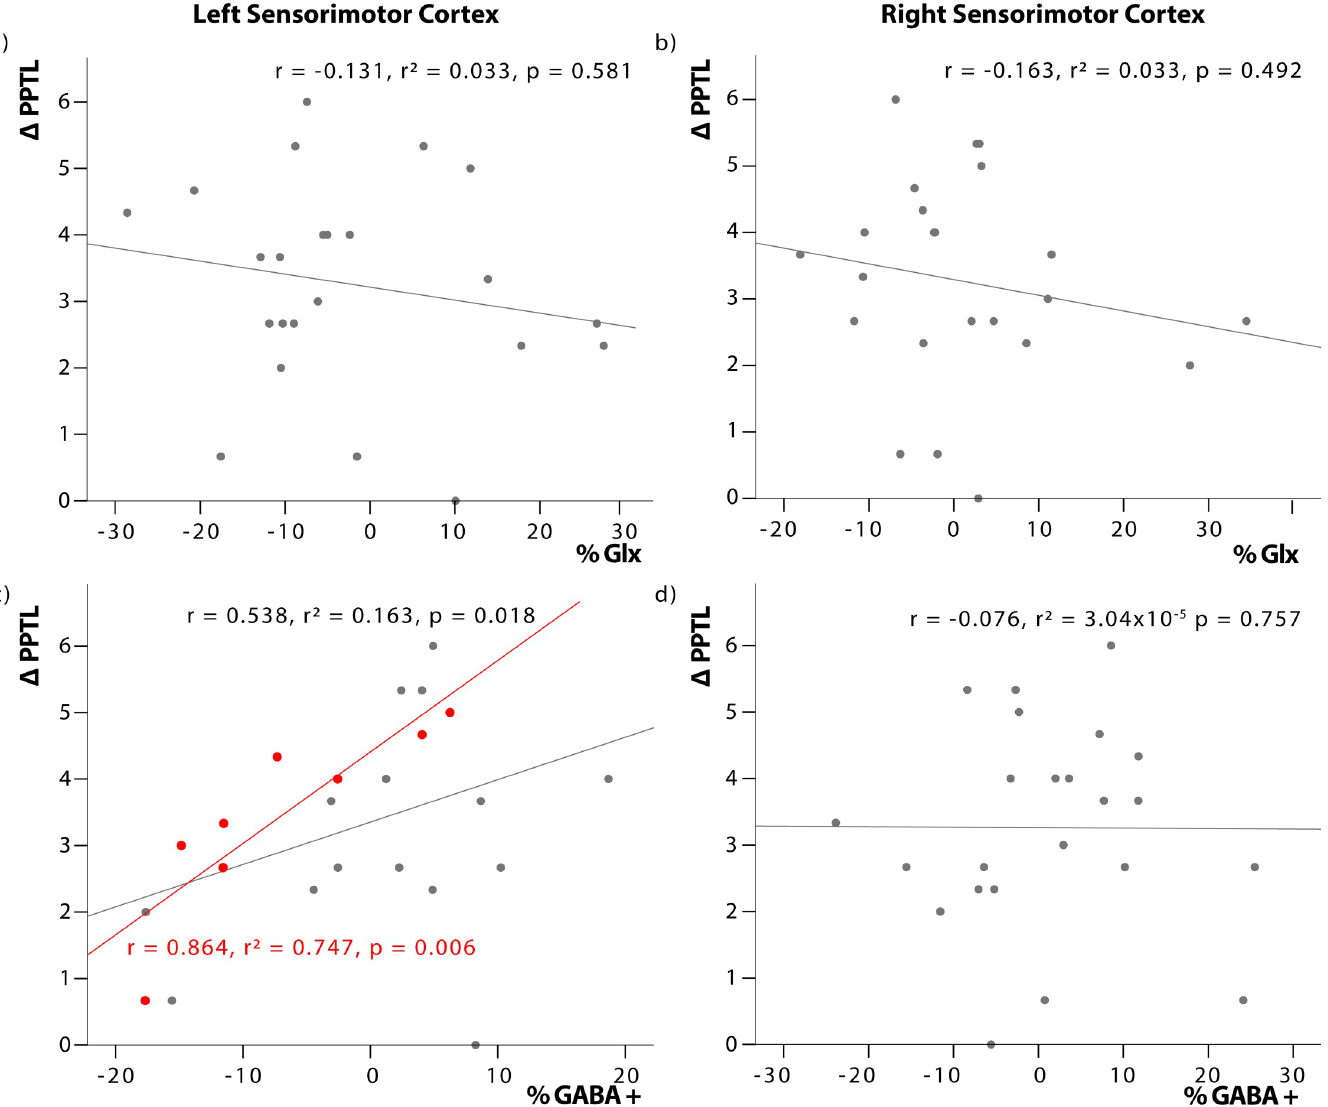
Fig 4. Relationship between changes in metabolite concentration and motor performance. Correlationn between change in metabolite concentration (% Glx and % GABA) and change in Purdue Pegboard Task post intervention ( Δ PPT L ) controlling for intervention group and age. Left sensorimotor cortex GABA is significantly correlated with PPT L for the pooled intervention groups (grey line). This relationship is also observed in the anodal tDCS intervention group (red).